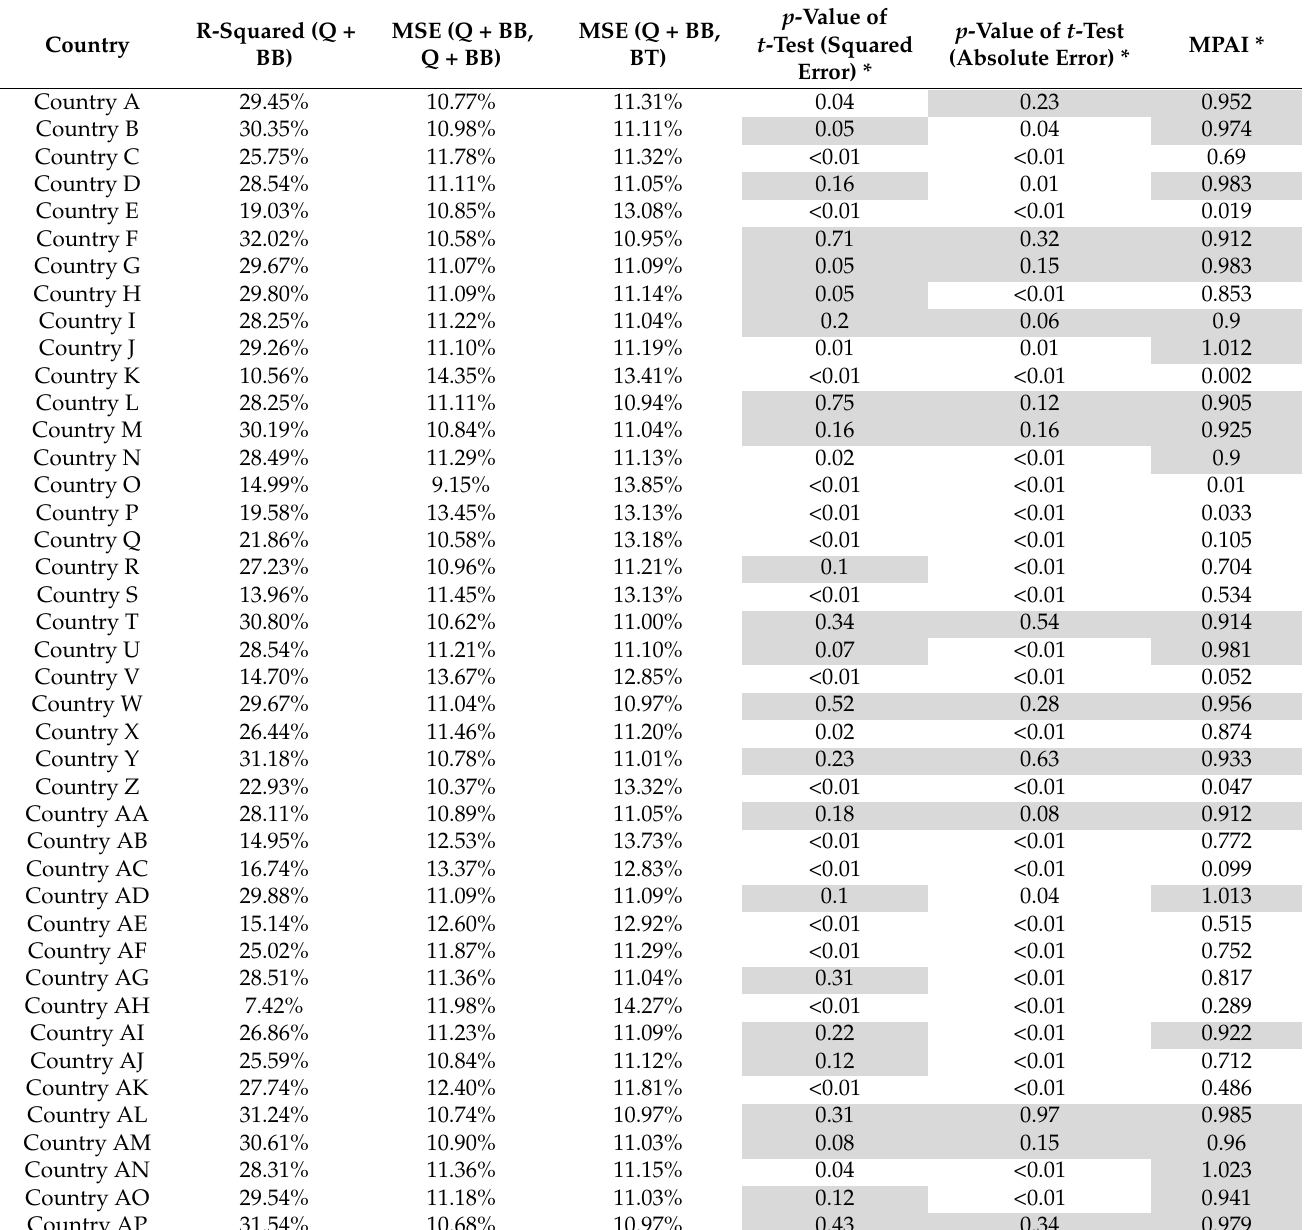
Table 10. Paired t -test results of the 42